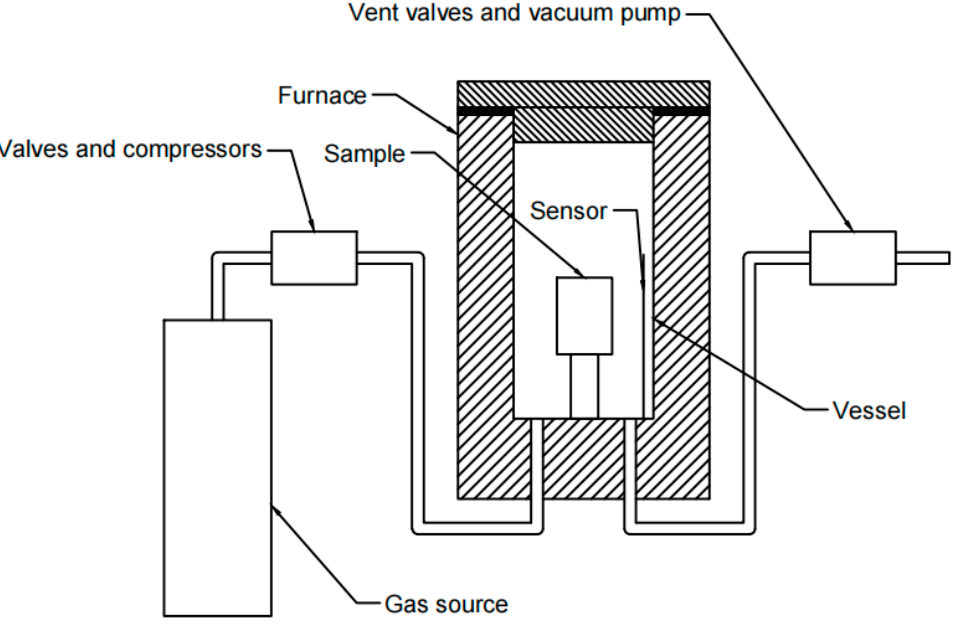
Figure 1. Schematic diagram showing the main structure of an HIP system.